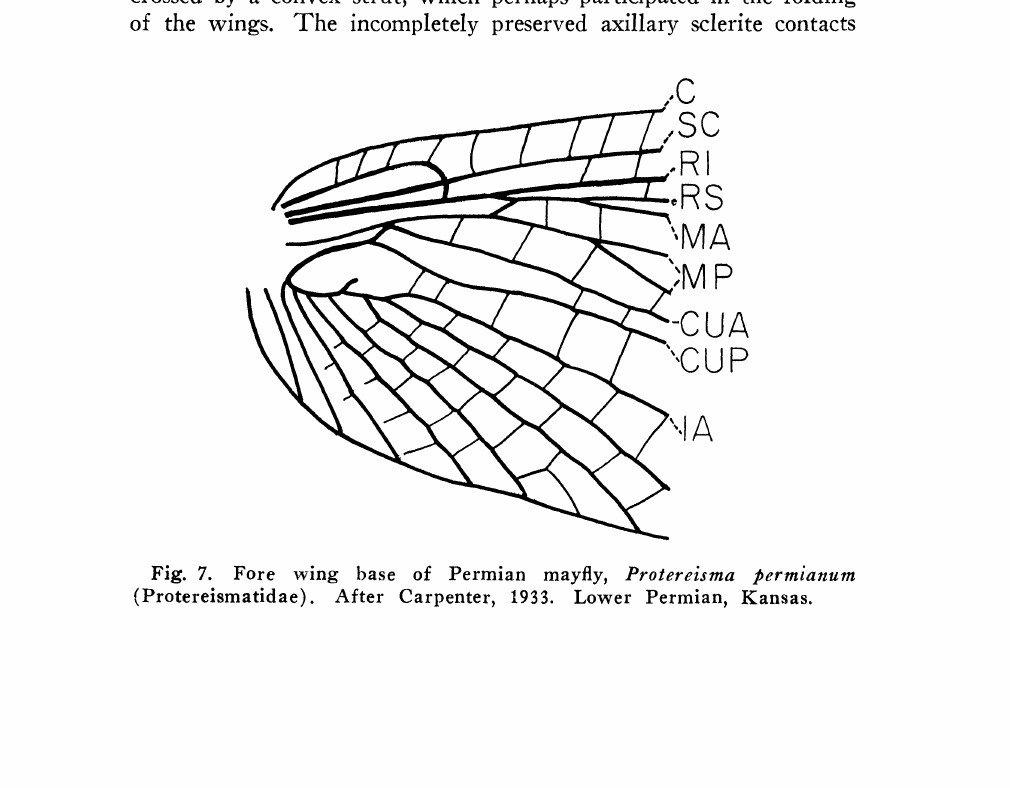
Fig. 7. Fore wing base of Permian mayfly, Protereisma permianum (Protereismatidae). After Carpenter, 1933. Lower Permian,